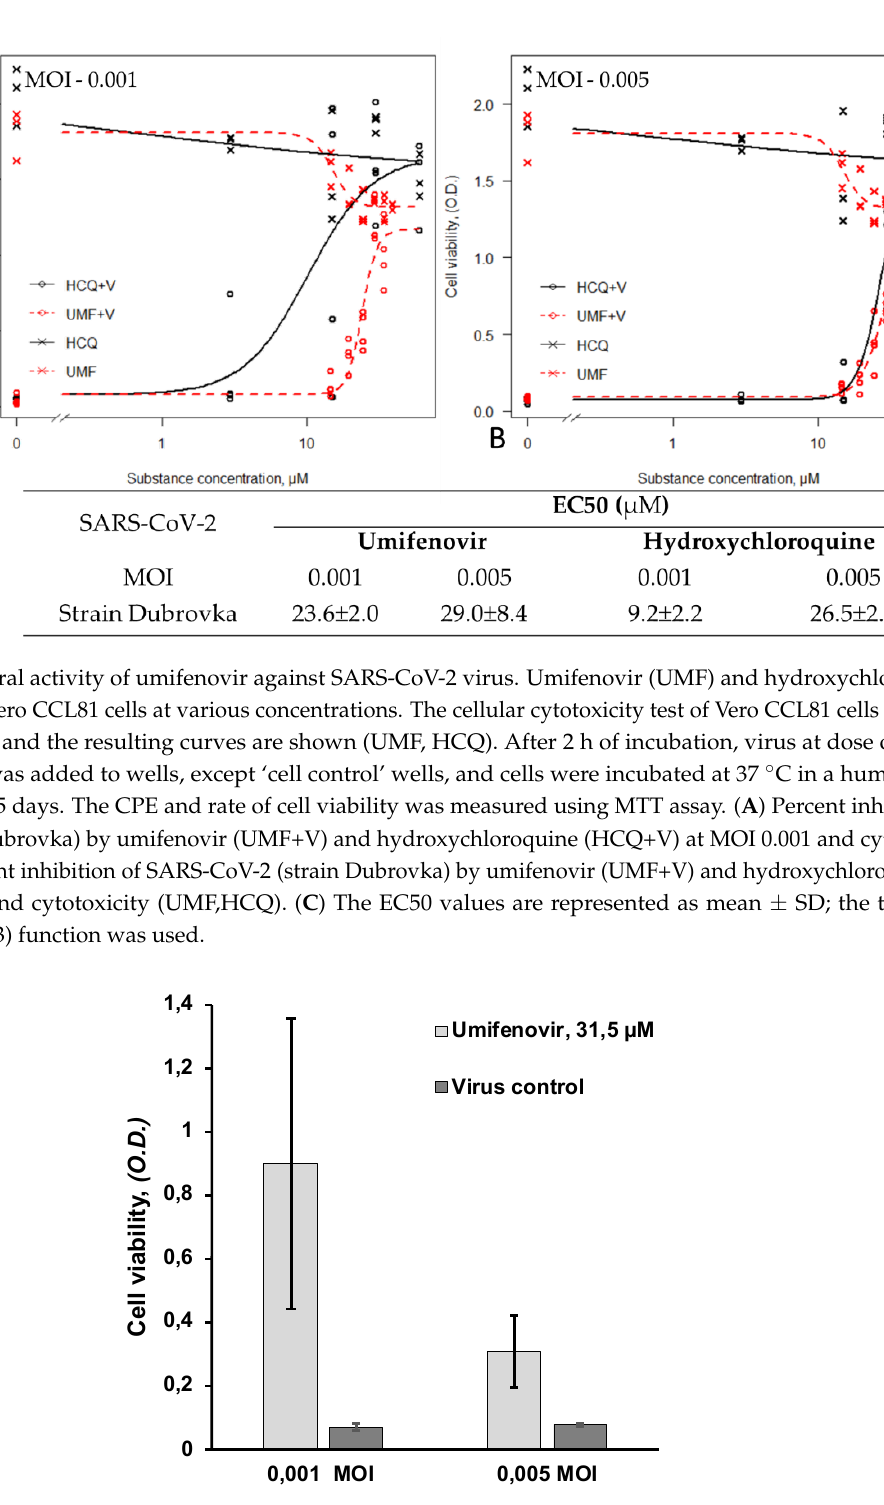
Figure 5. Effects of low and high multiplicity of infection on umifenovir antiviral activity. SARS- CoV-2 Dubrovka strain-infected Vero CCL81 cells were pre-treated with 31.5 µ M umifenovir for 2 h at 0.001 and 0.005 MOI. After incubation for 5 days at 37 ◦ C in a humidified 5% CO 2 atmosphere, the cell viability was estimated by MTT assay. The optical density (OD) is shown as the mean ± SD. Data represent three replications. Cell control—1.59 ± 0.42 ( n = 6), umifenovir control (without virus)—1.47 ± 0.54 ( n =